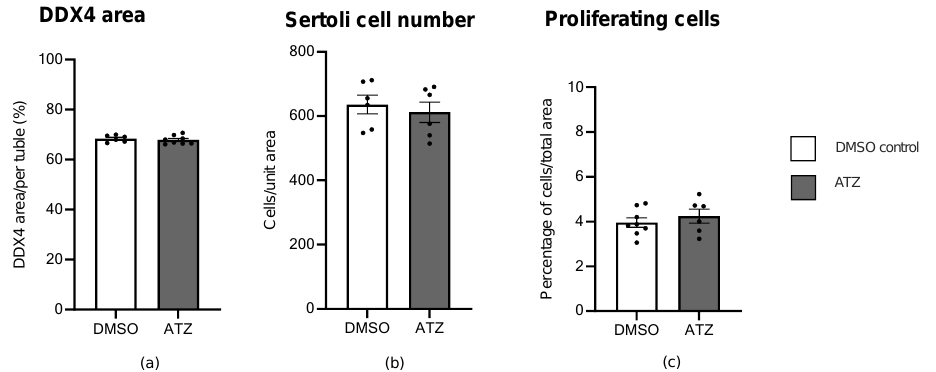
Figure 5. Analysis of atrazine exposure on the number of cell sub-types within the testis at 6 months of age in the F1 cohort. ( a ) DDX4 area was represented as a percentage area per tubule. ( b ) Sertoli